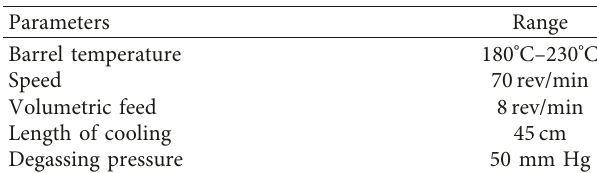
Table 1: Process parameters for the production of PE/C3B/EAC nanocomposites.